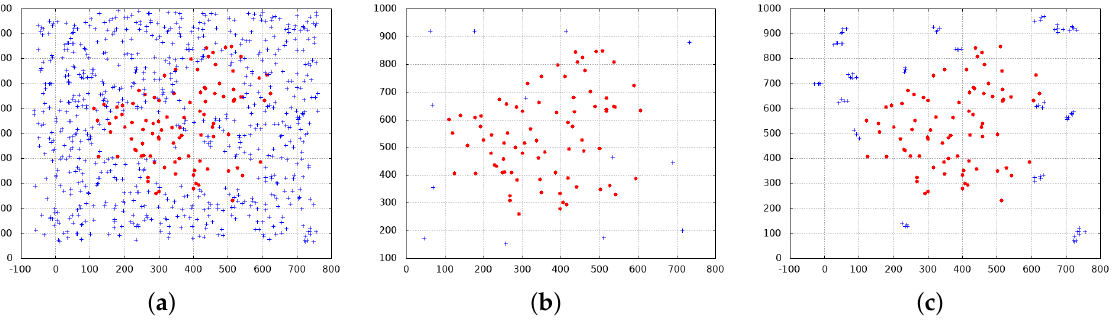
Figure 6. Scatter plots of the paw-50 database for the non-preprocessed set and the sets yielded by ClusterOSS and DBMIST-US. ( a ) Original; ( b ) ClusterOSS; ( c )